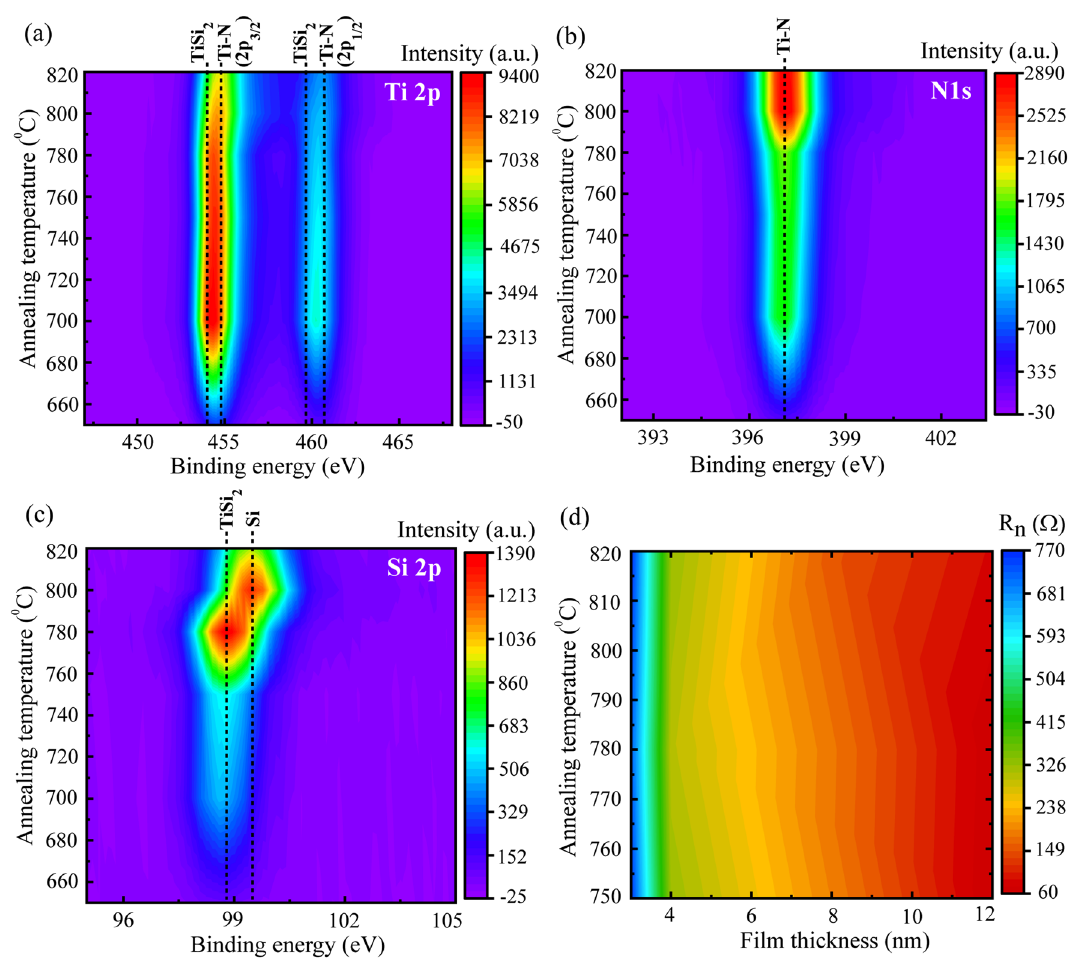
Figure 2. Core-level XPS binding energy spectra of ( a ) Ti 2p, ( b ) N 1 s and ( c ) Si 2p for reference samples annealed with varying annealing temperatures. The XPS spectra were taken from inside the films after removing the top surface by Ar + ion sputtering at 500 eV for about 2 min. ( d ) Variation in the R n with the variations in T a and thickness of the